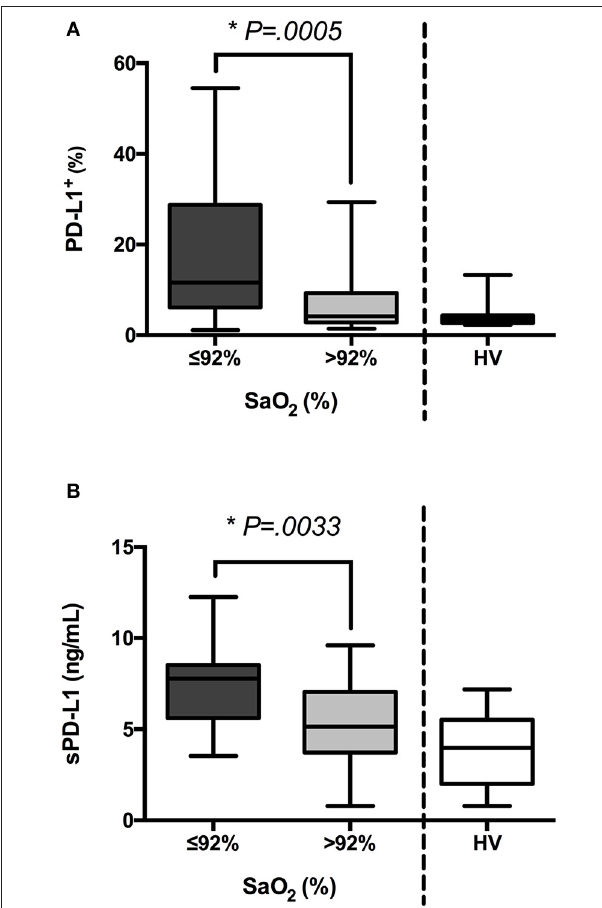
FIGURE 5 | Levels of both sPD-L1 in sera and PD-L1 on CD14 + cells correlate with oxygen saturation in patients with sepsis. (A) Concentrations of sPD-L1 were quantified in sera from patients with sepsis ( n = 85) by ELISA. The correlation between sPD-L1 and levels of oxygen saturation is shown. (B) Percentages of PD-L1 + cells gated on CD14 + cells from patients with sepsis ( n = 62) were analyzed by FACS. The correlation between PD-L1 and levels of oxygen saturation is shown. * p < 0.05 using Spearman’s